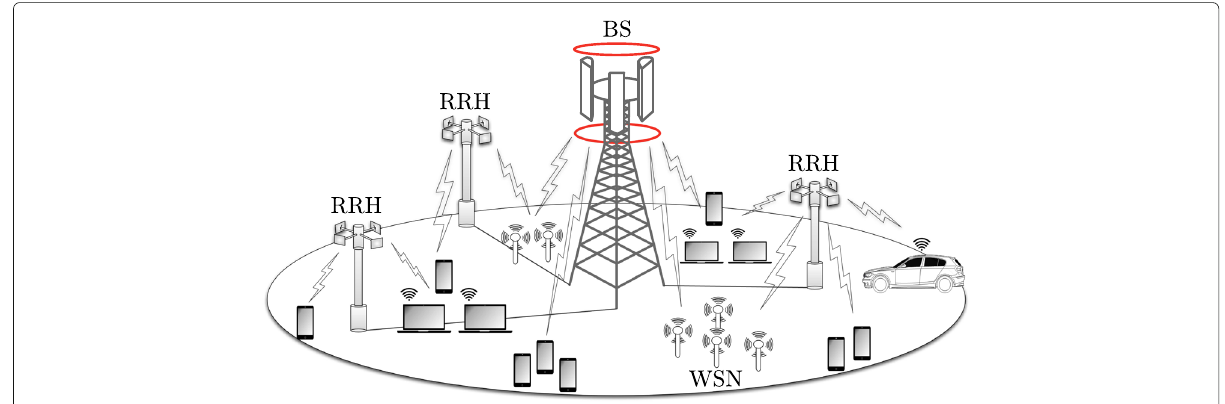
Fig. 1 Heterogeneous wireless network: base station (BS), remote radio head (RRH), and wireless sensor networks (WSN)